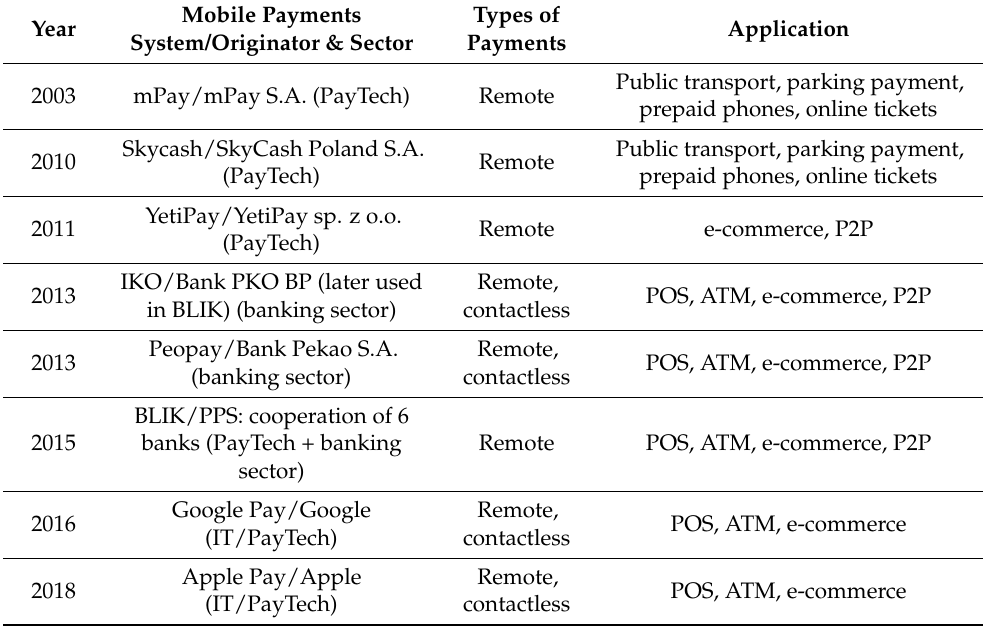
Table 5. The most important retail mobile payments solutions in